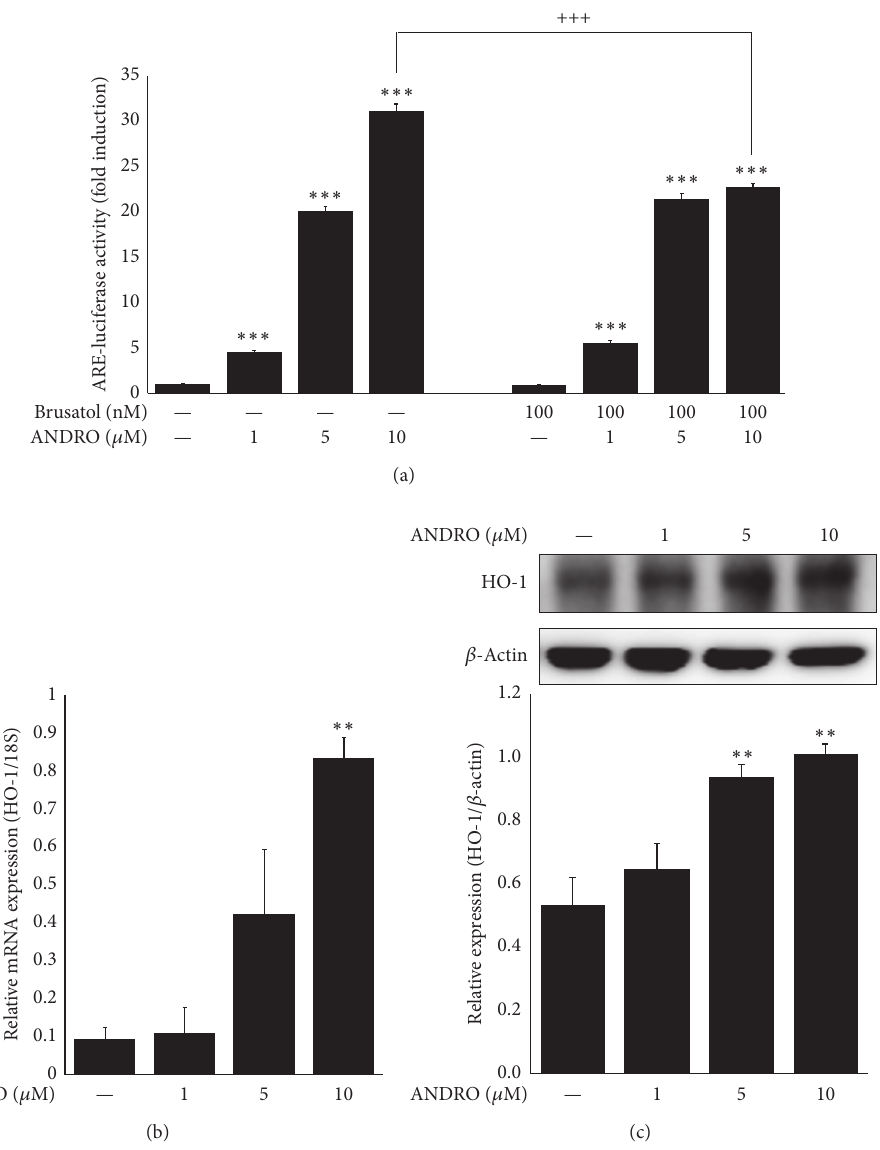
Figure 3: Effect of andrographolide on ARE gene transcriptional activity and HO-1 expressions. The abbreviation of andrographolide, ANDRO, was used. (a) HT22-ARE cells were treated with 100nM brusatol for 2 h prior to andrographolide treatment at 1, 5, or 10 𝜇 M concentrations for 16 h. The cells were lysed, and the lysates were used to determine luciferase activity. The data are presented as the means ± SE of triplicates. The significance presented as ∗∗∗ 𝑝 < 0.001 compared with control group, +++ 𝑝 < 0.001 compared with the brusatol- untreated group. (b) Relative mRNA expression levels of Nrf2 were regulated after andrographolide treatment. HT22 cells were seeded onto 12-well plates at 1.5 × 10 5 cells per a well and treated with 1, 5, and 10 𝜇 M andrographolide for 24 h. The mRNA was extracted, cDNA was synthesized, and the relative expression levels of mRNA were determined. (c) HO-1 expression after andrographolide treatment at 1, 5, or 10 𝜇 M concentrations for 24 h in HT22 cells was determined by Western blot analysis. The data are presented as the means ± SE of triplicates. The significance presented as ∗∗ 𝑝 < 0.01 compared with control